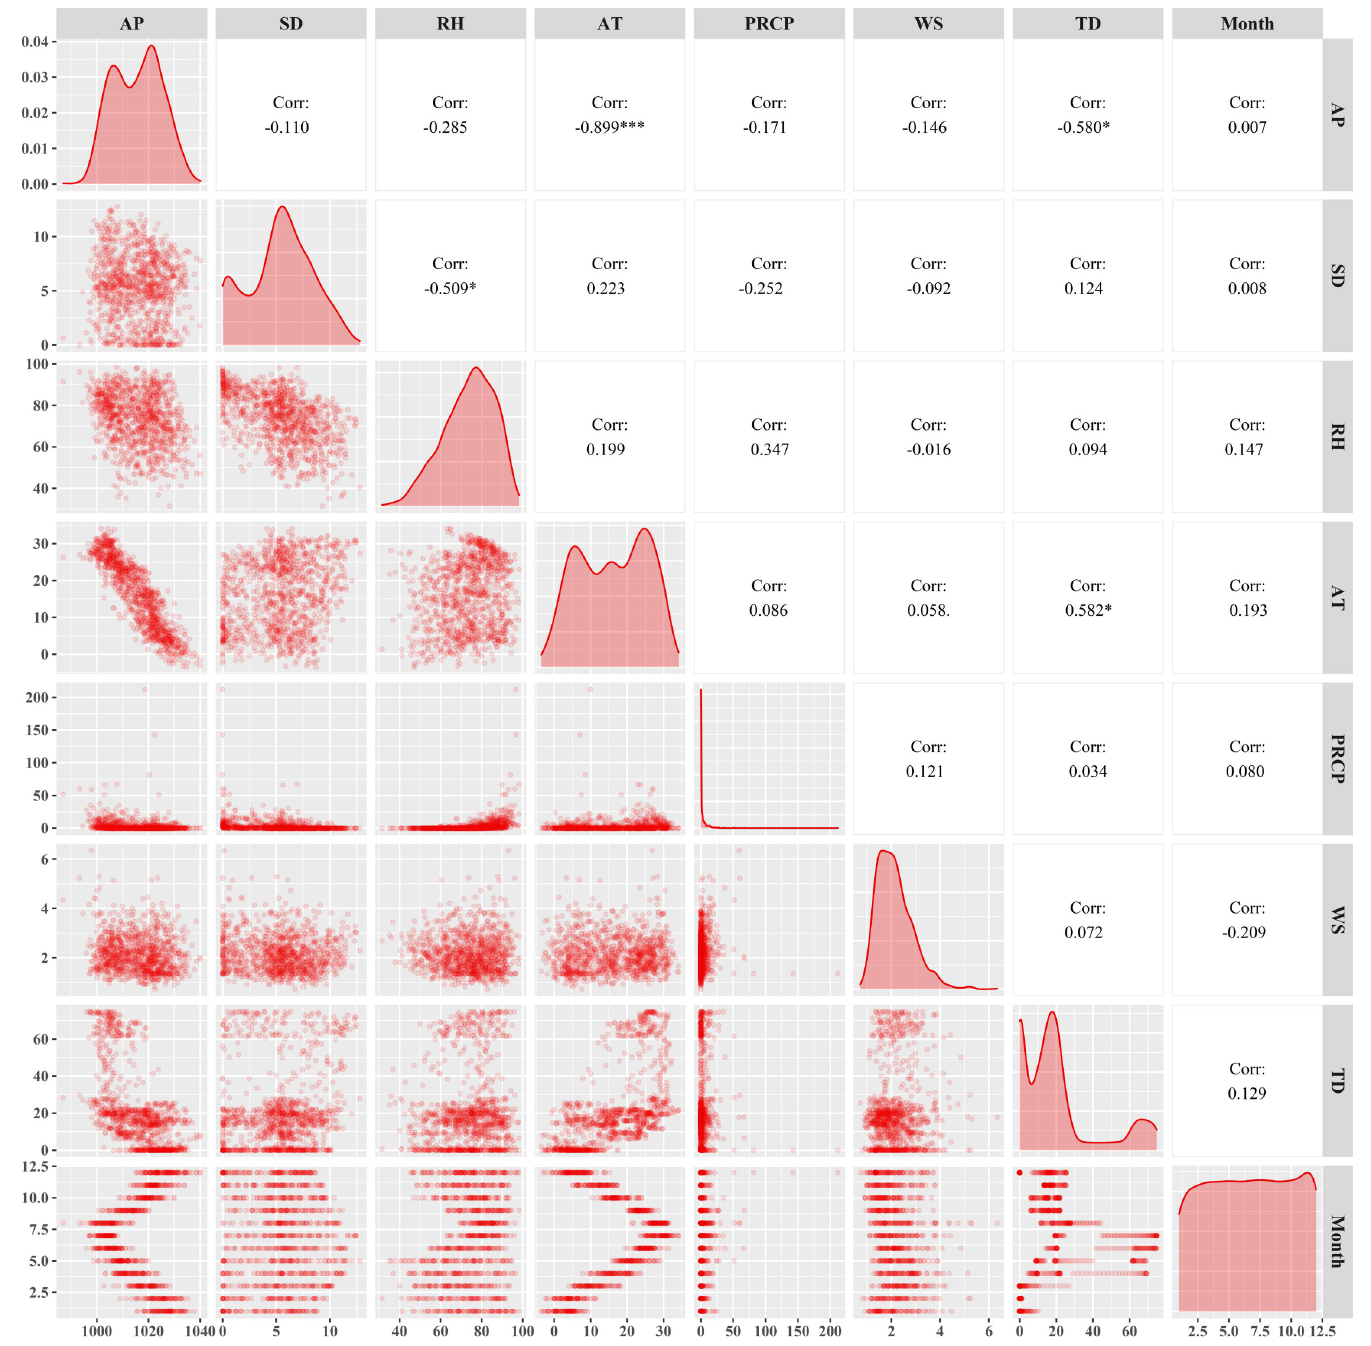
Fig 4. Correlation analysis between no time lagging meteorological factors and tick density. AP = Air pressure; SD = Sunshine duration; RH = Relative humidity; AT = Average temperature; PRCP = 24-hour precipitation; WS = Wind speed; TD = Tick density. Correlation coefficient (r) greater than 0.7 indicates a strong correlation between the